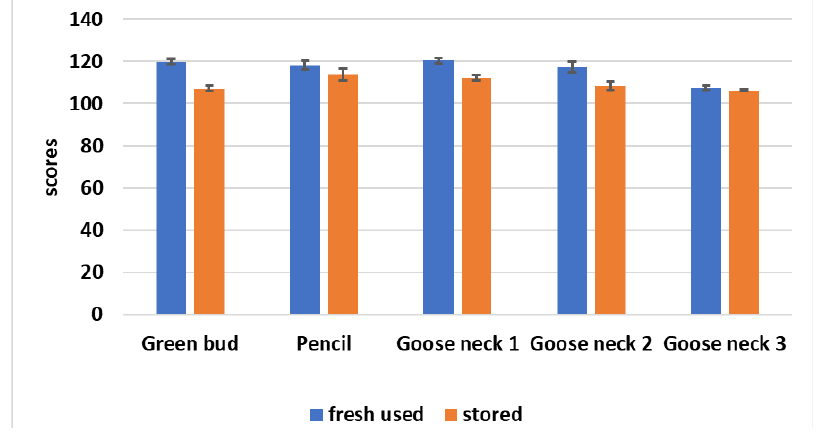
Figure 10. Sum of 12 h interval ornamental values. Bud stages: green bud (GB); pencil: white bud, upright (PE); goose neck 1: white bud, skew (GN1); goose neck 2: white bud, horizontal (GN2); goose neck 3: big white bud, horizontal, maximum with 1 opening petal (GN3).